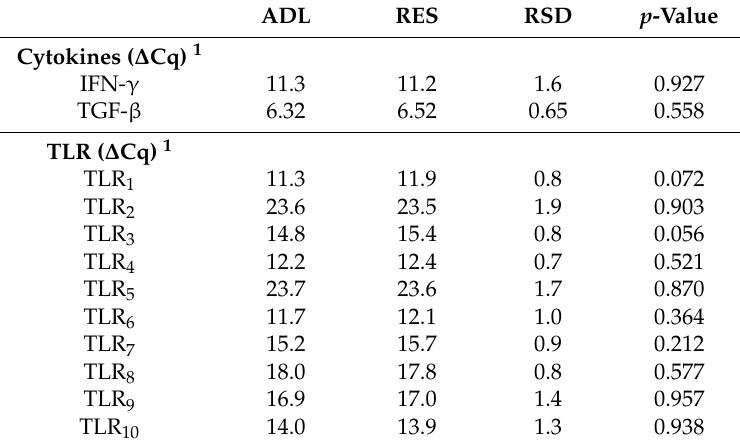
Table 3. Cytokines and toll-like receptors (TLRs) mRNA expression in ruminal mucosa of fattening lambs being fed ad libitum (ADL) or restricted (RES) diets during the suckling period. ADL